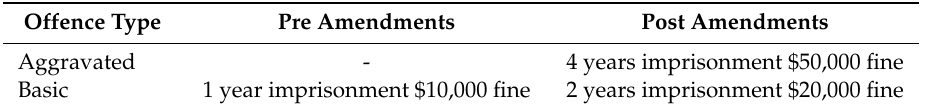
Table 2. Status of the maximum penalties for both aggravated and basic offences before and after the 2008 amendments to the AWA. Aggravated offence was introduced after the